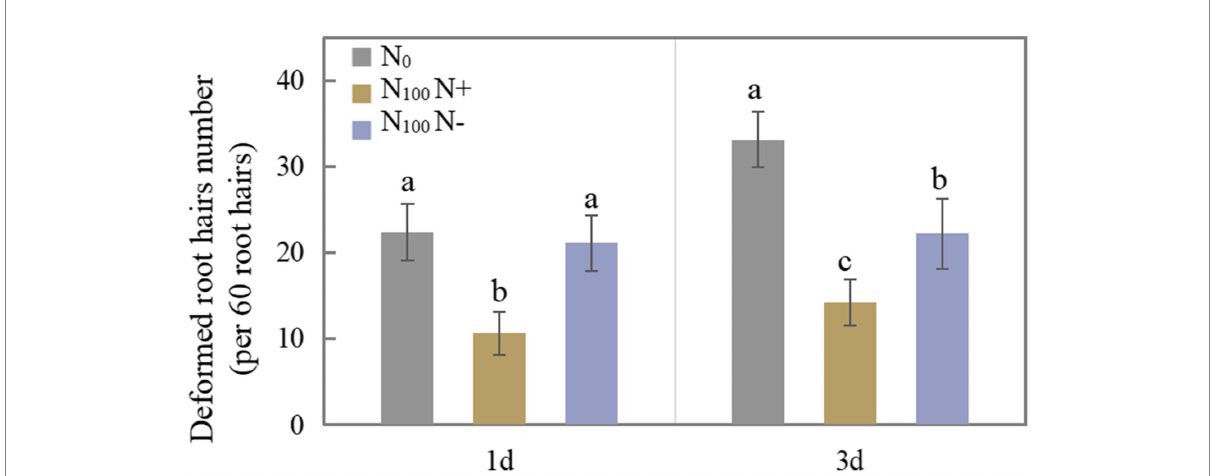
FIGURE 1 Number of deformed root hairs of dual-root soybeans, N 0 is N-free nutrient solution on both sides of dual-root soybeans, N 100 N+ is N-supply side of dual-root soybeans treated with 100 mg/l nutrient solution on unilateral side, N 100 N-is N-free side of dual-root soybeans treated with 100 mg/l nutrient solution on unilateral side, different lowercase letters above the bars indicate significant difference ( p < 0.05) by Duncan’s multiple range test.